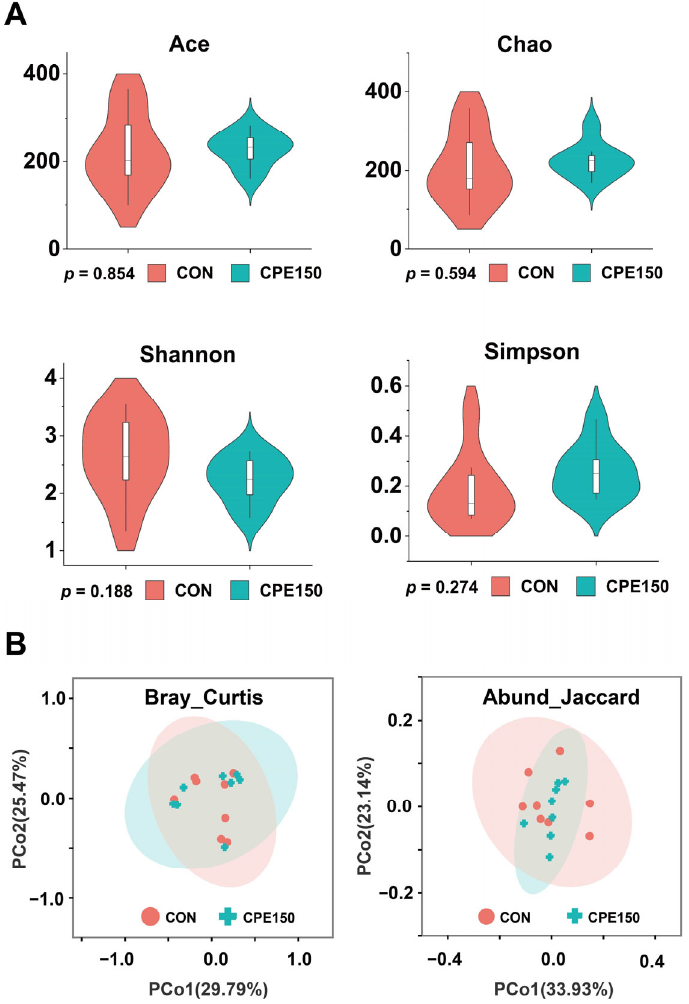
Figure 1. Comparison of the bacterial diversity between the milk of cows fed the control diet (CON), and supplementary citrus peel extracts at 150 g/d (CPE150). ( A ) Alpha diversity indices, including Ace, Chao, Shannon, and Simpson; ( B ) PCoA plots based on the Bray–Curtis and Abund–Jaccard metrics.